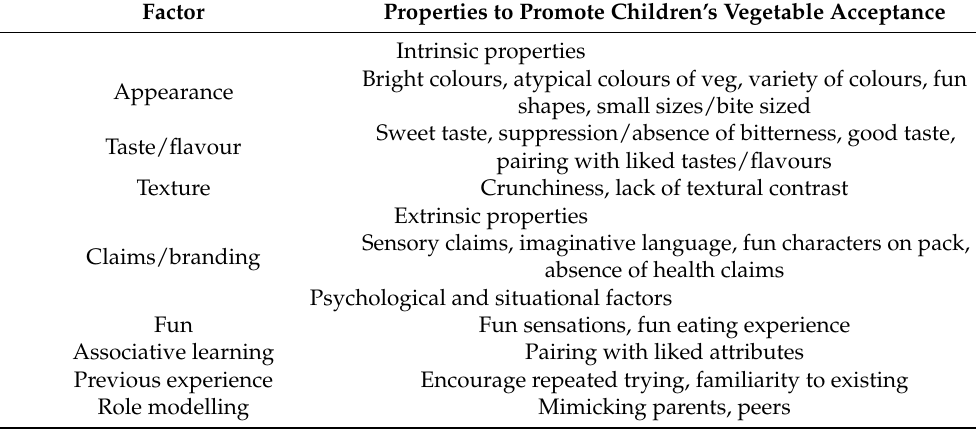
Table 1. Children’s Acceptance Model for Product development Of Vegetables (CAMPOV model).